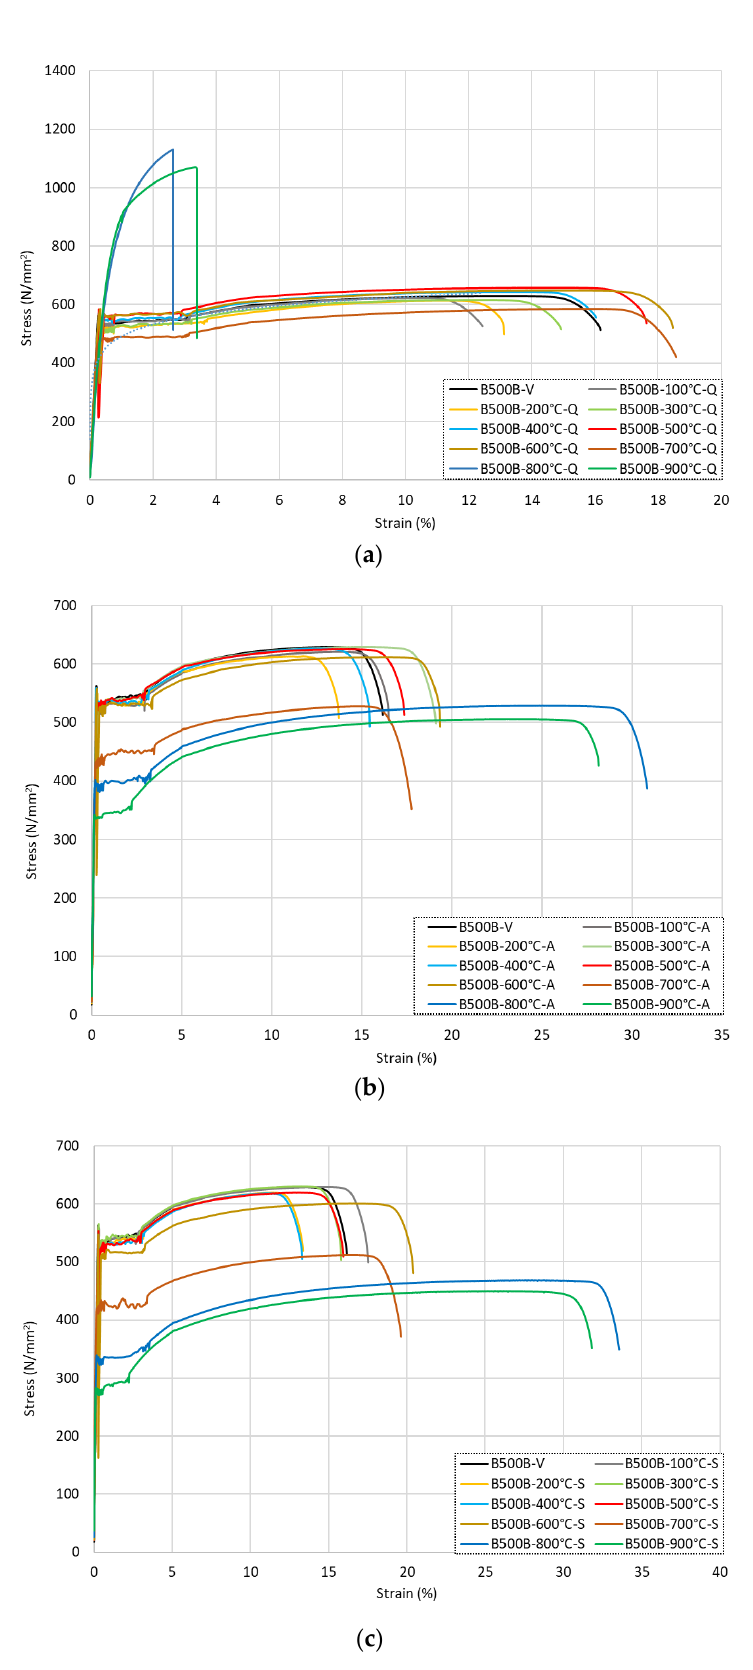
Figure 10. Stress – strain responses for B500B carbon steel rebars following exposure to elevated temperatures and then being ( a ) quenched in water, ( b ) cooled naturally in air, and ( c ) slow-cooled in the furnace.